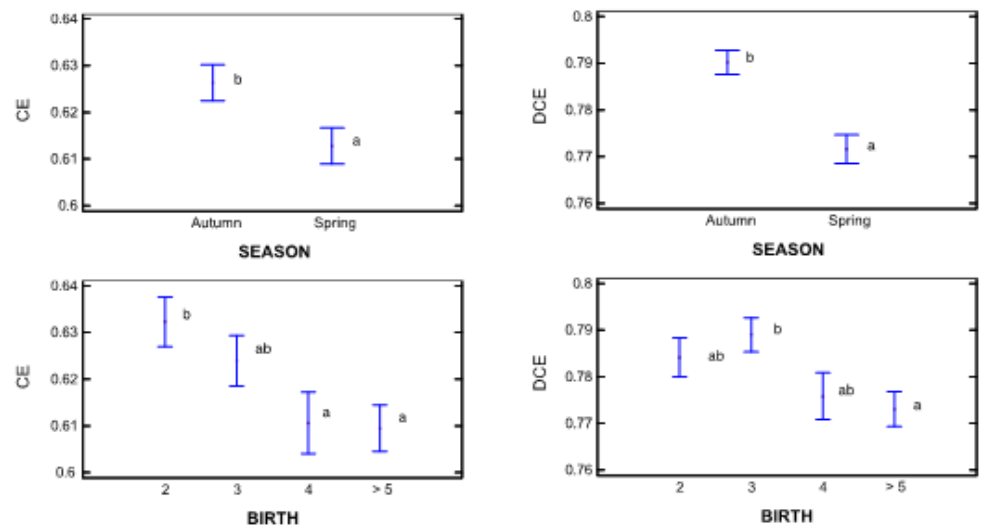
Figure 5. Bivariate association (ANOVA or Student’s t ) between curd efficiency and the categorical Figure 1. This is a figure. Schemes follow the same formatting. If there are multiple panels, they factors evaluated (mean ± standard error). Left column = CE, right column = DCE. “a”, “b”, and “ab”: Means without a common letter are significantly different at p < 0.05 according to Student’s t should be listed as: ( a ) Description of what is contained in the first panel. ( b ) Description of what is test or SNK post hoc test ( n = contained in the second panel. Figures should be placed in the main text near to the first time they are cited. A caption on a single line should be centered. Table 1. This is a table caption. Tables should be placed in the main text near to the first time they are cited.